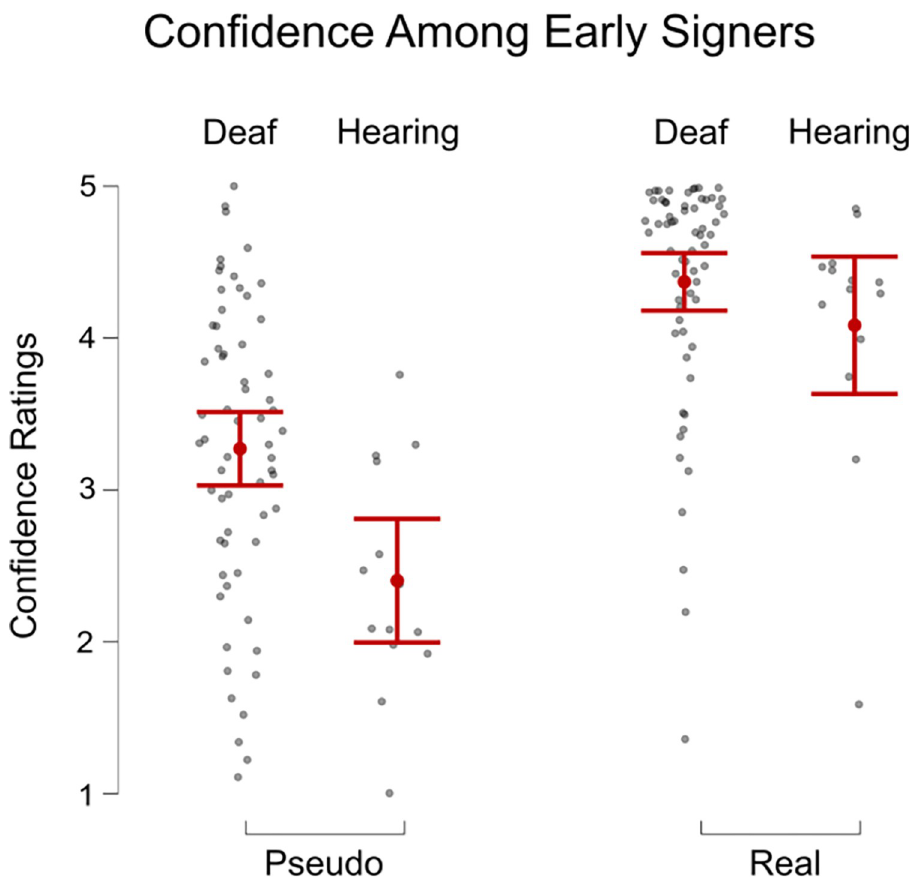
Fig 8. Confidence ratings of responses to pseudo names compared to real names by deaf and hearing groups who learned ASL at or before age 3. The error bars on the Fig show standard error.